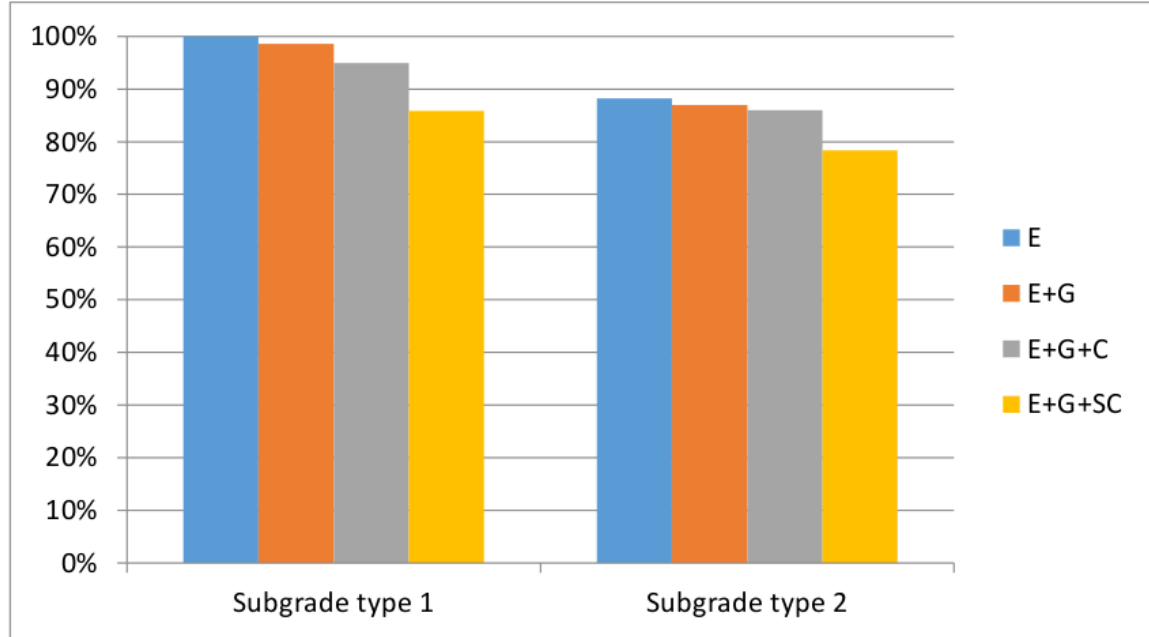
Figure 14. Total deformation of the embankment for all four types of structure and for two types of subgrade with various modulus of